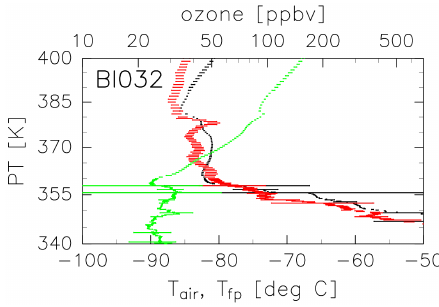
Fig. 8. Vertical profiles of frost point temperature (red), temperature (black), and ozone mixing ratio (green) observed at Biak (04:35UT, 16 January 2007). The horizontal bars show the uncertainties of sonde measurements estimated by Hasebe et al. (2013) (see ap- pendix A in their paper).